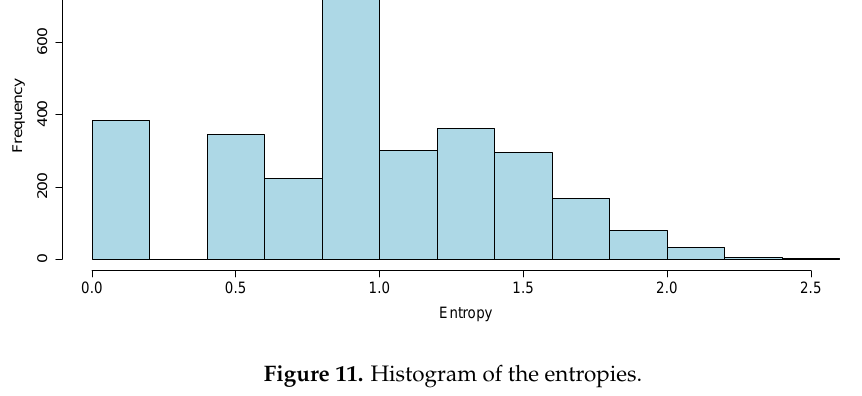
Figure 11. Histogram of the entropies.